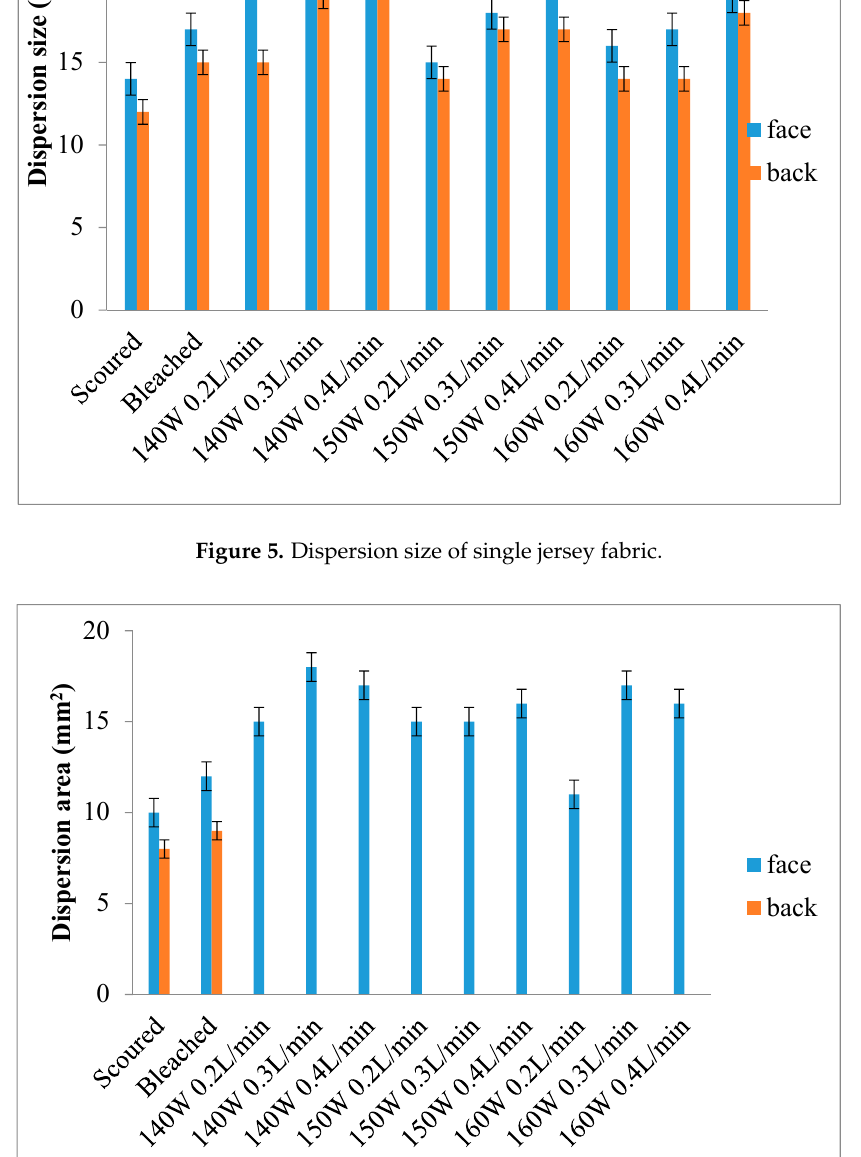
Figure 6. Dispersion size of interlock